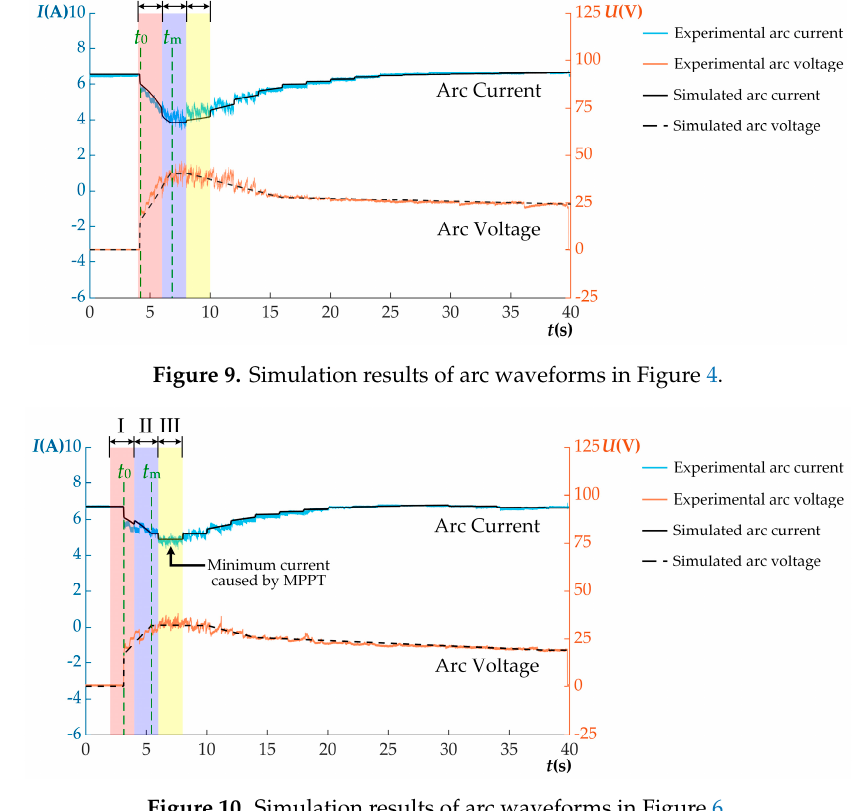
Figure 10. Simulation results of arc waveforms in Figure 6.